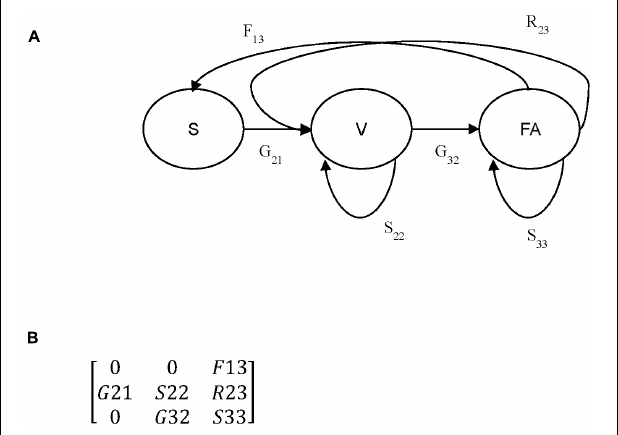
FIGURE 1 | (A) Life cycle diagram for Crepidium acuminatum . Circles represent individual life stages: (S) seedlings, (V) non-flowering adults, (FA) flowering adults. Arrows represent all possible transitions: (G nm ) growth, (S nm ) survival), (R nm ) retrogression and (F nm ) fertility, between each of three life stages, where m is the initial stage and n is the subsequent stage. (B) Generalized population projection matrix corresponding with the life cycle diagram in (A)